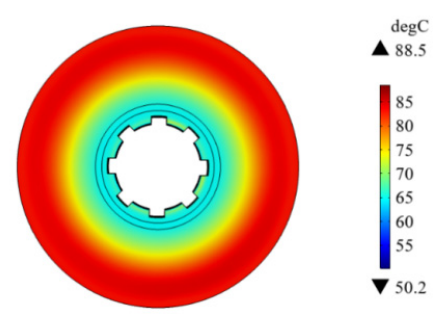
Figure 17. Clutch temperature fi eld simulation results.